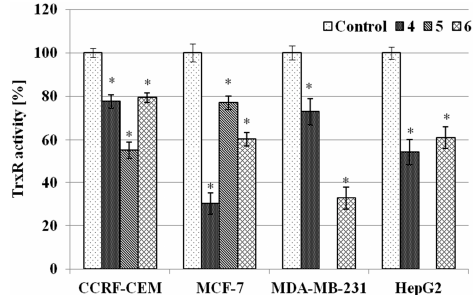
Figure 5. Relative activity of TrxR in human cancer cells treated with complexes 4 , 5 and 6 for 24 h. Enzyme activity was estimated at the end of the incubation period and compared to the untreated control of the corresponding cell line (100%). Each experiment was done at least in triplicate. The results represent means ± SEM of data from 3 to 4 individual experiments, * p < 0.05 vs. control.